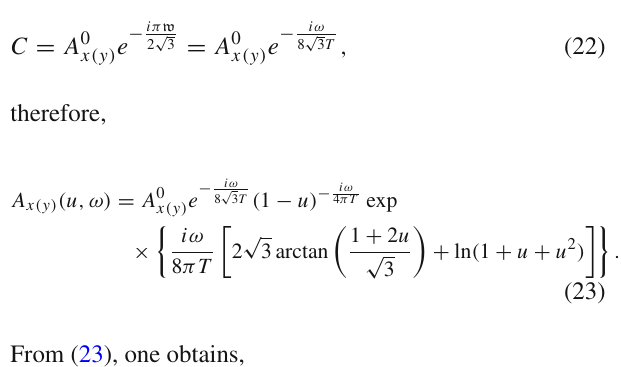
Fig. 3 Real and imaginary parts of the diagonal AC conductivity as functions the θ -angle and the dimensionless frequency variable, w = 3 ω/ 4 π T , for C (cid:12) = (cid:12) L / 2 = 2 (dimensionless combination involv-